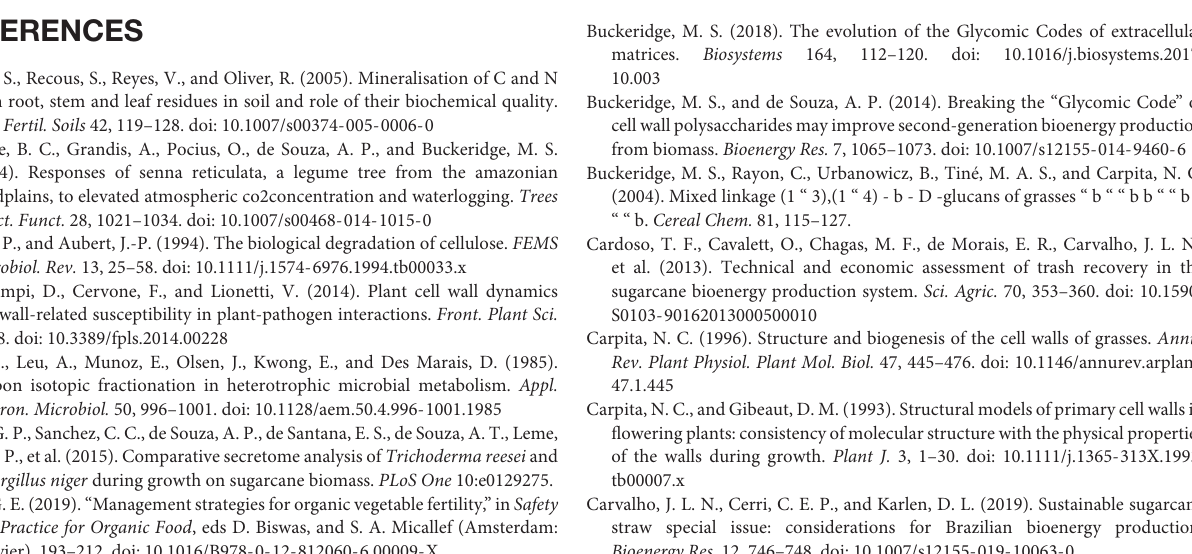
Supplementary Figure 1 | Distance biplots from significative monosaccharides from cell wall fractionation in straw on the field in the period of 1 year. (A) The centroids separation corresponds to the straw harvest distribution for months in the plane defined by the first and second main components (PC1 and PC2). (B) Plot of the PC1 and PC2 loading vectors, describing the relationship among variables of straw composition during the harvests. Percentage values in parentheses ( x and y axes) show the proportion of the variance explained by each axis. The variables analyzed were expressed in descriptor vectors from significant ( P < 0.05) monosaccharides in cell wall fractionation describe in Table 2 . For statistics by PC1 and PC2 see Supplementary Table 3 ( n = 5). Supplementary Table 1 | Relative percentage of cell wall composition statistic data. Values are represented by mean ± standard error. Different letters are significant differences by Tukey’s test ( P < 0.05; n = 5). Supplementary Table 2 | Eigenvalues, proportions, and cumulative variance corresponding to each of the axes (PC1 and PC2) generated by the Principal Components Analysis (PCA) of the straw from five harvests, for 1 year. Values of the coefficients calculated for each of the variables measured along with the experiment of the of cell wall components (AIR Samples), non-structural carbohydrates, ash, saccharification, lignin, soil humidity, Uronic Acid, Carbon and Nitrogen (C and N), C/N ratio, 15 N, and 13 C parameters. ANOVA one-way test was performed to test the significance of the synthetic variables for each principal component (PC) and expressed in F and P -values. In bold the main vectors to represent the PC and bold/italic correspond to significant differences in PC for the time of harvest (0, 3, 6, 9, and 12 months; n = 5). Supplementary Table 3 | Eigenvalues, proportions, and cumulative variance corresponding to each of the axes (PC1 and PC2) generated by the Principal Components Analysis (PCA) of the straw from five harvests, for 1 year. Values of the coefficients calculated for each principal component in significative values ( P < 0.05), from monosaccharide composition in a complete cell wall fractionation ( Table 2 ). ANOVA one-way test was performed to test the significance of the synthetic variables for each principal component (PC) and expressed in F and P -values. In bold the main vectors to represent the PC and bold/italic correspond to significant differences in PC for the time of harvest (0, 3, 6, 9, and 12 months; n =